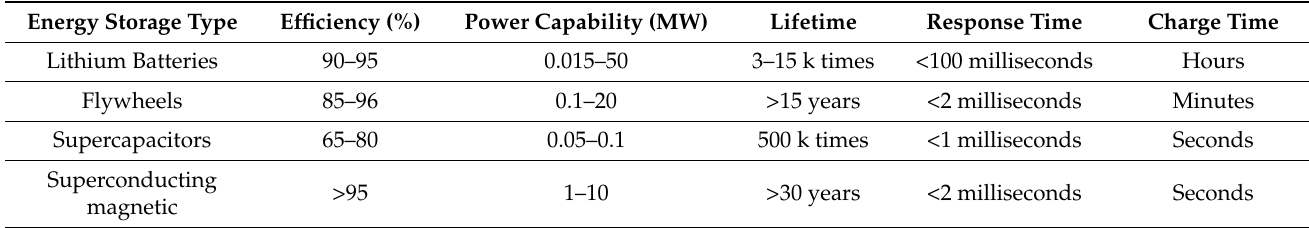
Table 3. Key properties of various energy storage